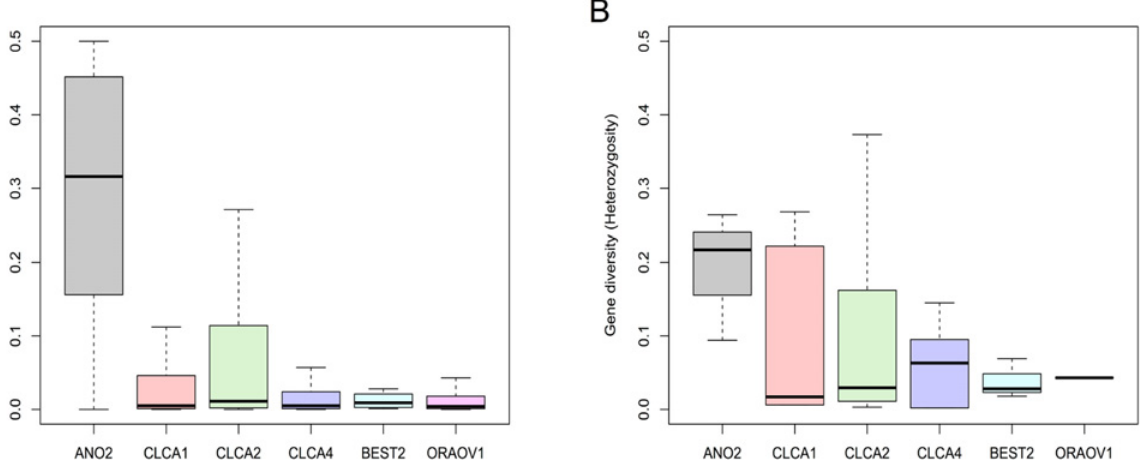
Figure 4. Gene diversity for TMEM16B/ANO2 . Gene diversity calculated in individuals of the 1000 Genomes Project using all the SNPs in the genes ( A ) or only the missense mutations ( B ). TMEM16B/ANO2 showed the highest gene diversity among the indicated genes both in A (p = 2.2e-16) and in B (p = 0.042).